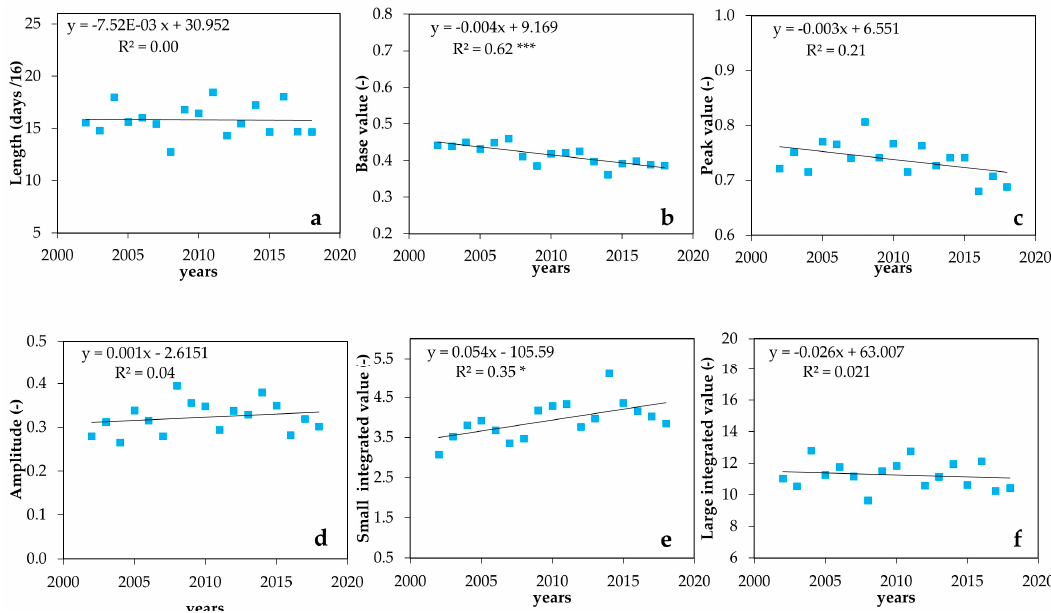
Figure 8. Seasonal parameters in CS1: ( a ) length value, ( b ) base value, ( c ) peak value, ( d ) amplitude value, ( e ) small seasonal integral and ( f ) large seasonal integral. Significant p -value ( p < 0.05, 0.01 and 0.001) are indicated with *, ** and ***, respectively.